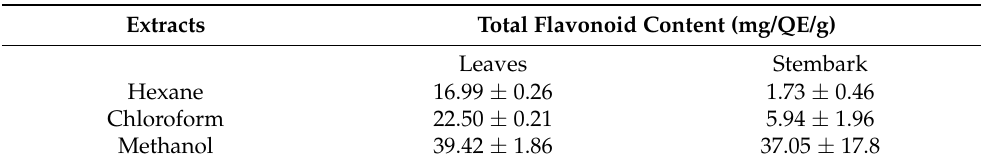
Table 4. Quantification of the total flavonoid content of the leaf and stembark extracts (hexane, chloroform, and methanol) of C. erythrophyllum